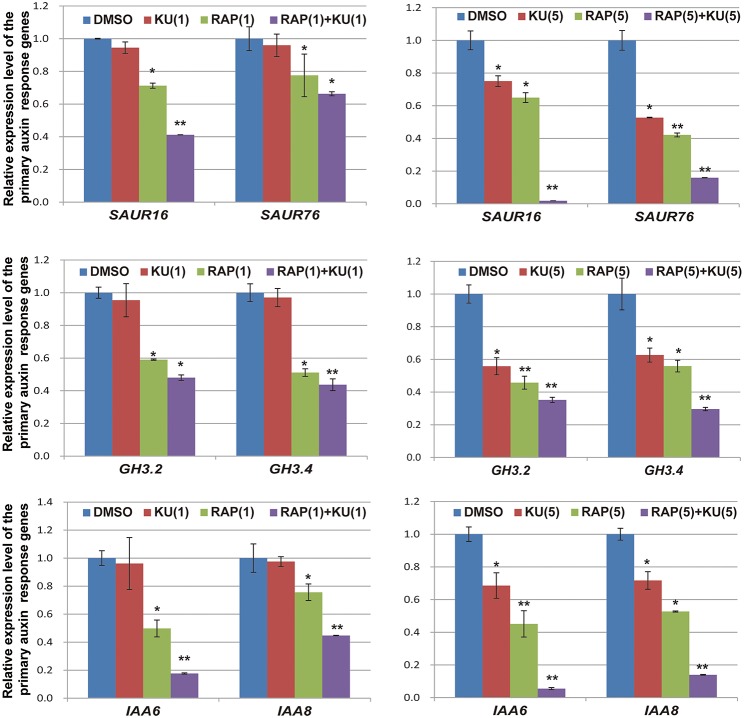
The expression level of primaryauxin response gene family AUX/IAAs, SAURs, and GH3s were affected by TOR specific inhibitors. DR5/BP12-OE11 grew in 0.5 MS medium containing TOR inhibitors [RAP (5 μM), KU (5 μM), RAP (5 μM) + KU (5 μM); DMSO was used as control)] for 12 days. Each value represents the mean± SD of 3 independent experiments. Asterisks denote Student's t-test significance compared with control (*P < 0.05; **P < 0.01).